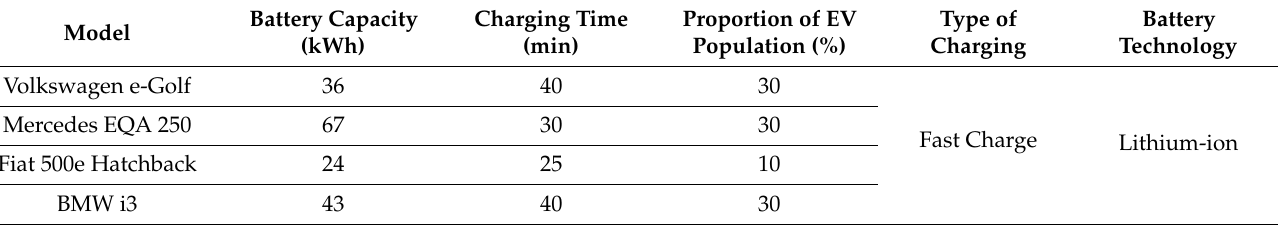
Table 1. Electronic Vehicle Characteristics Summary